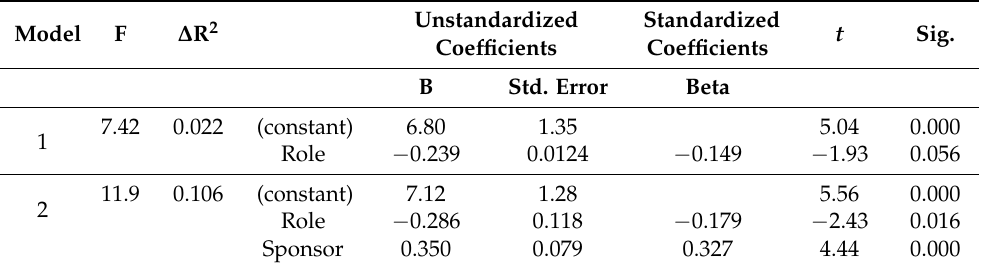
Table 9. Hierarchical Regression Coefficients.